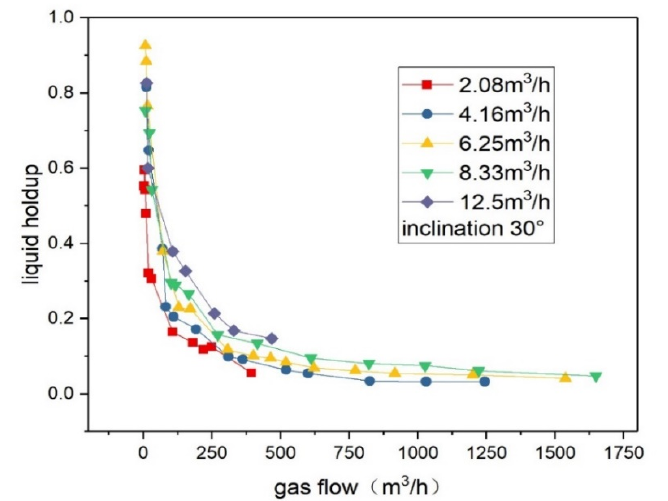
Figure 10. Variation of liquid holdup with gas flow rates under different liquid volumes at an inclination angle of 30 ° .